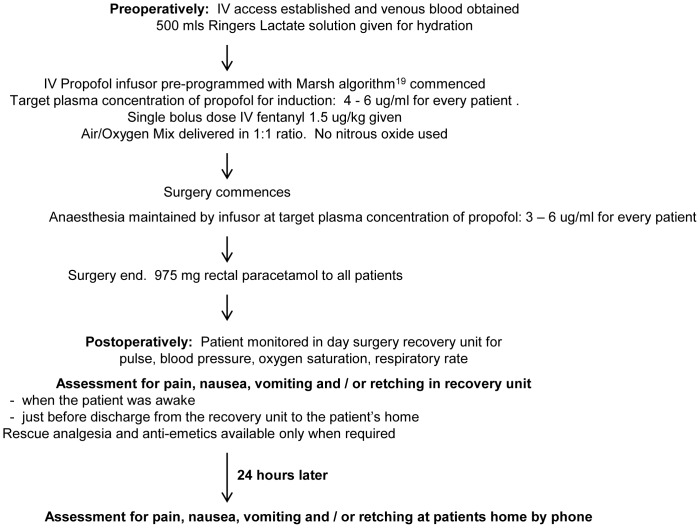
Flowchart of study perioperative anaesthetic protocol of low emetogenicity for minor gynaecological day surgery.No prophylactic anti-emetics were given pre and intraoperatively. Total intravenous anaesthesia (TIVA) using an intravenous (IV) target controlled infusion (TCI) of propofol, was administered using a propofol infusor (Asena PK Syringe Pump, Carefusion USA). The infusor was pre-programmed with the Marsh algorithm [18], which computed propofol dosing rates to attain a target perioperative plasma propofol concentration of 4–6 ug/ml and 3–6 ug/ml in the induction and maintenance phase of anaesthesia respectively in every patient.